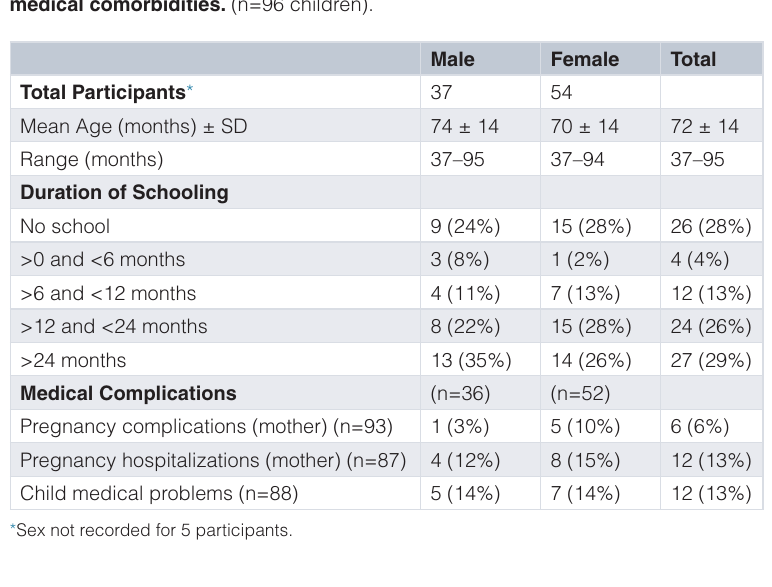
Table 2. Participant characteristics at time of enrollment: age, education, medical comorbidities. (n=96